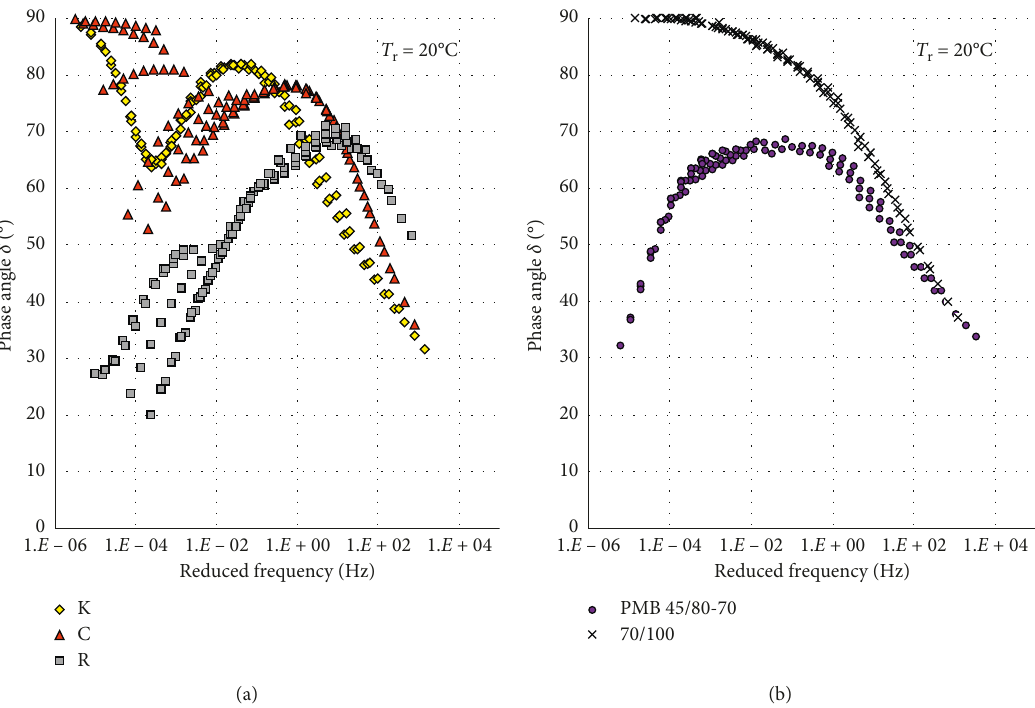
Figure 6: δ master curves for the selected binders in comparison with bituminous binders.